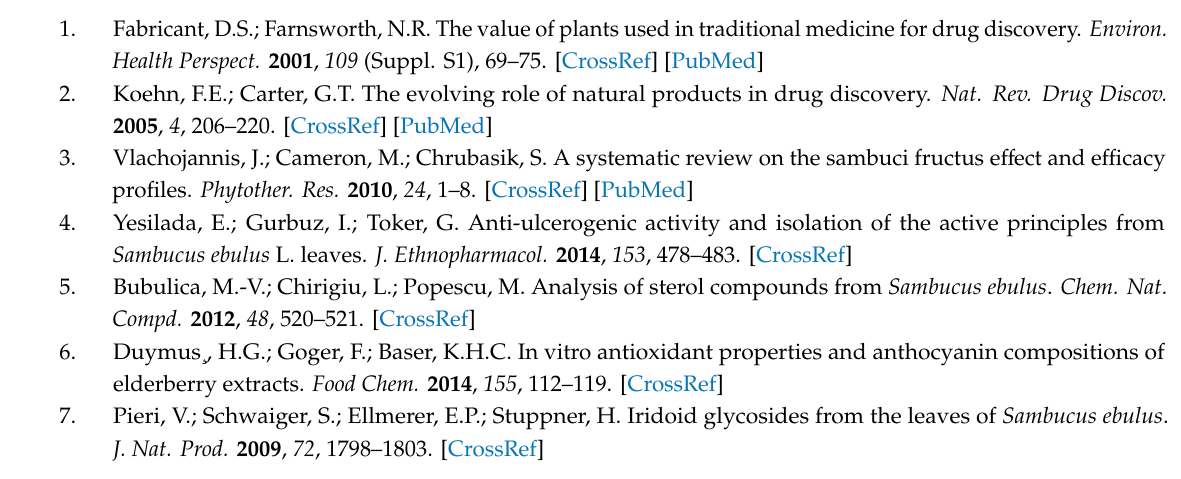
Figure S1: Influence of a single factor on entrapment e ffi ciency of SE extract-loaded liposomes: PC / cholesterol ratio (A), evaporation temperature (B), stirring rate (C), SE extract amount (D); Figure S2: Influence of a single factor on entrapment e ffi ciency of SE extract-loaded transfersomes: PC / sodium cholate ratio (A), evaporation temperature (B), stirring rate (C), SE extract amount (D); Figure S3: Influence of a single factor on entrapment e ffi ciency of SE extract-loaded ethosomes: PC / SE extract ratio (A), water / ethanol ratio (B); Figure S4: SEM image of freeze dried SE extract-loaded liposomes; Figure S5: Enhanced color view 2D AFM of SE extract-loaded lipid vesicles: liposomes (A), transfersomes (B) and ethosomes (C); Figure S6: SEM images of SE extract loaded lipid vesicles dried in vacuum; Table S1: Standard HPLC phenolic compounds: retention time ( RT ) and standard deviation (SD), maximum wavelength ( λ max ), calibration curve y = ax + b and correlation coe ffi cients ( R 2